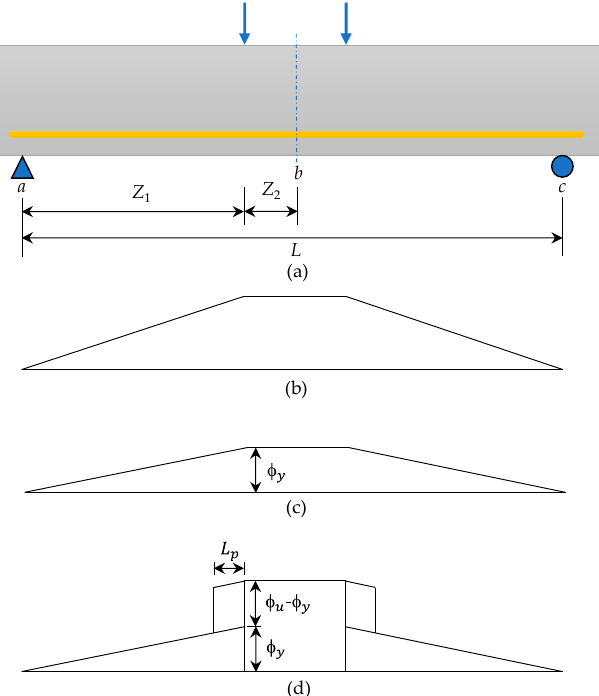
Figure 24. Schematic diagram of the curvature area theorem for obtaining a typical beam deflection: ( a ) load diagram, ( b ) bending moment diagram, ( c ) idealized curvature at the yielding stage, and ( d ) idealized curvature at the ultimate stage.